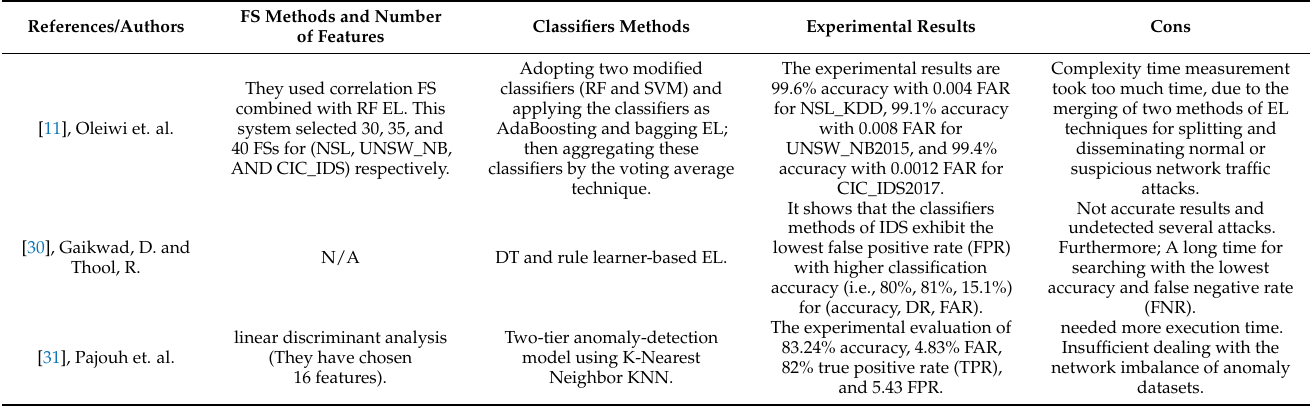
Table 1. Similar related